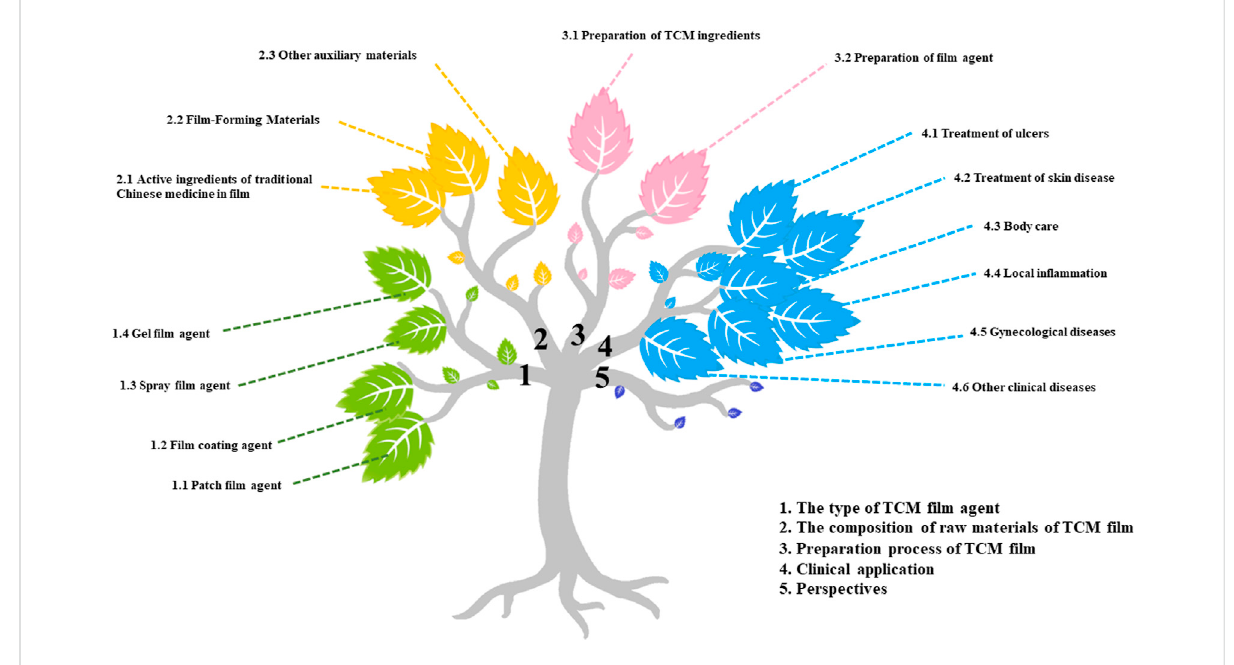
FIGURE 1 Mind map of the